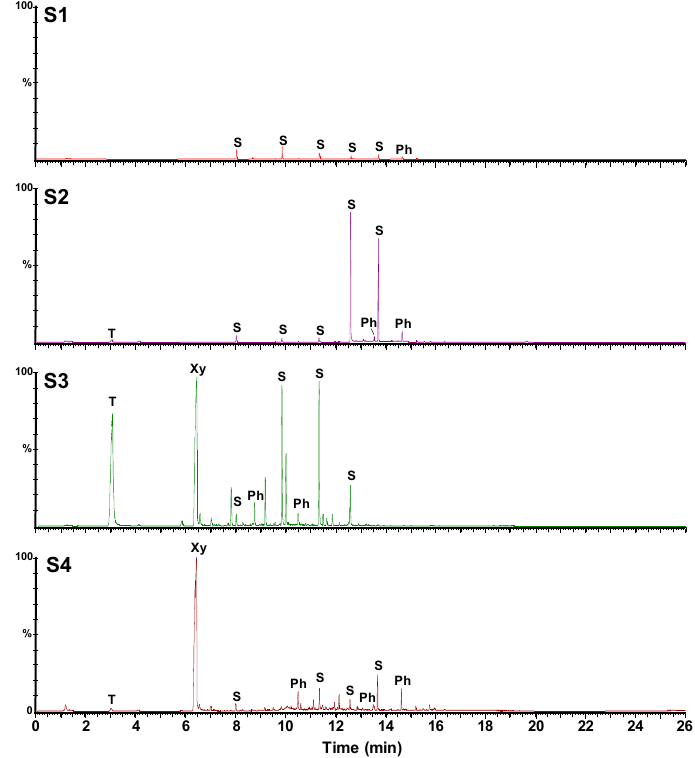
Figure 8. GC-MS (gas chromatography–mass spectrometry) chromatograms of the four C 60 samples (T: toluene, Xy: xylene, S: siloxane derivatives, Ph: phthalate derivatives). These data show that the GC-MS method can be used after appropriate calibration and validation to quantify the residual solvents and other volatile impurities in a C 60 sample. Table 2. Detected impurities in the four C 60 samples (semi-quantitative aspect; − absence; and + presence).